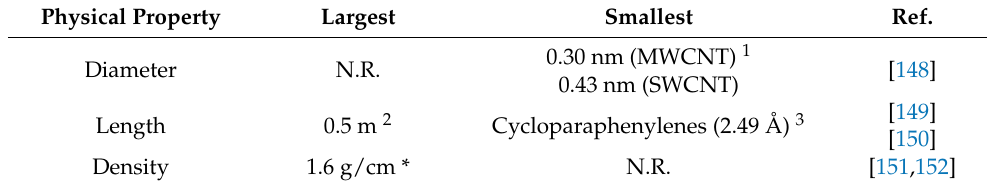
Table 7. Physical limits of CNTs produced so far.